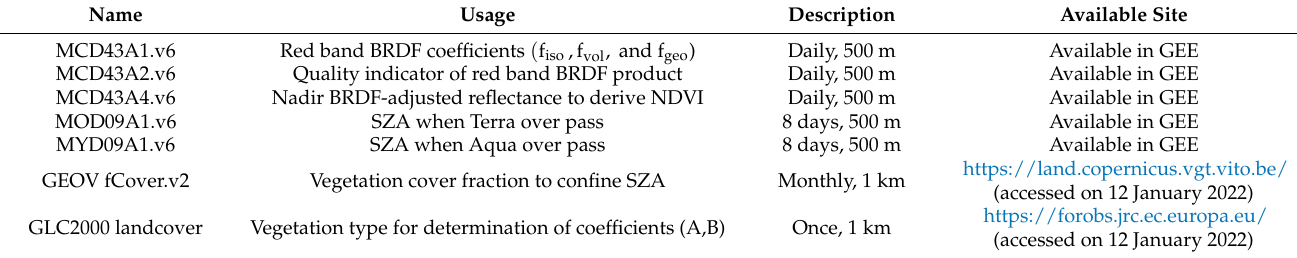
Table 1. Remote sensing data sets used in the CI retrieval. The column description lists the temporal and spatial resolutions of datasets. MODIS products have been archived in GEE; last two data were uploaded manually to the